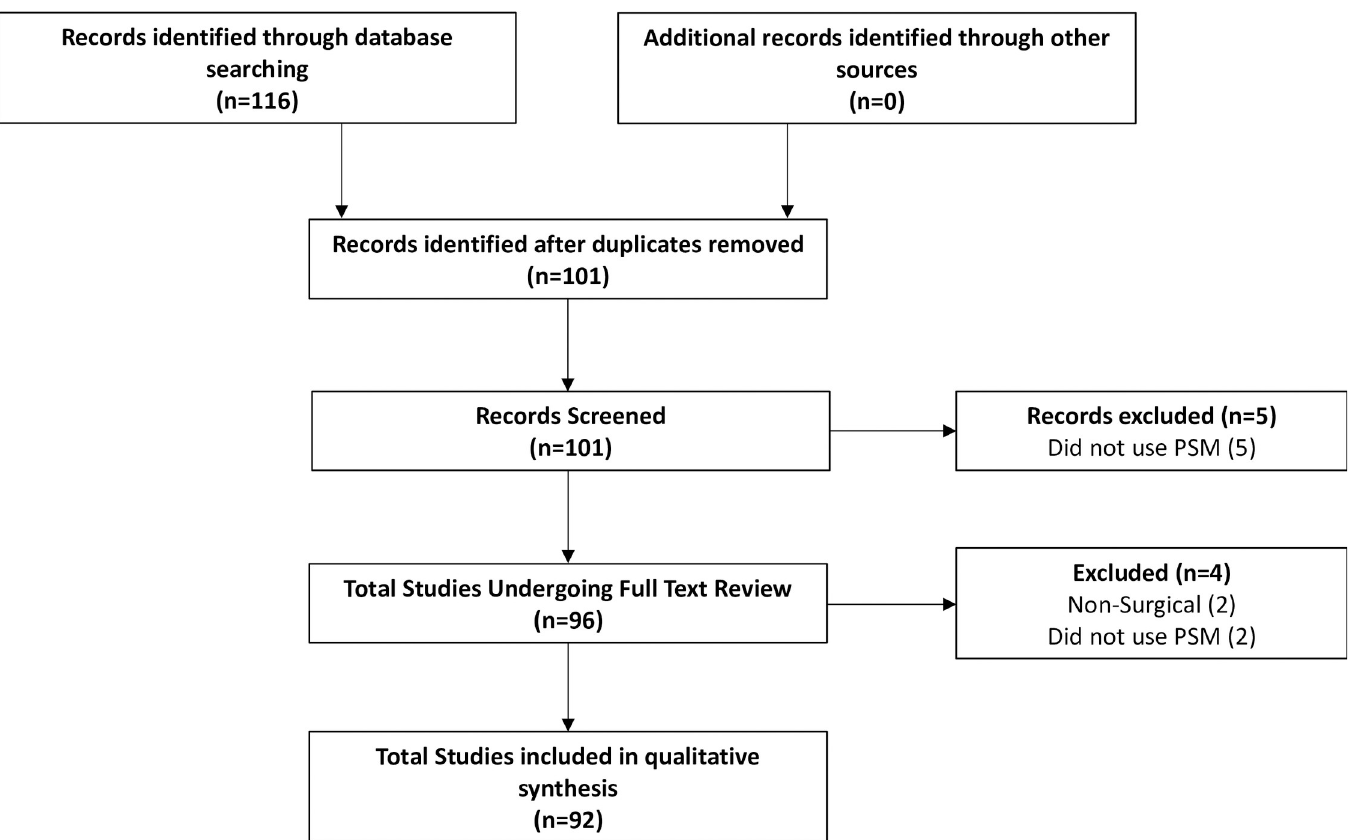
Fig 1. PRISMA flow diagram of our search strategy demonstrating the total number of studies reviewed and reasons for exclusion.